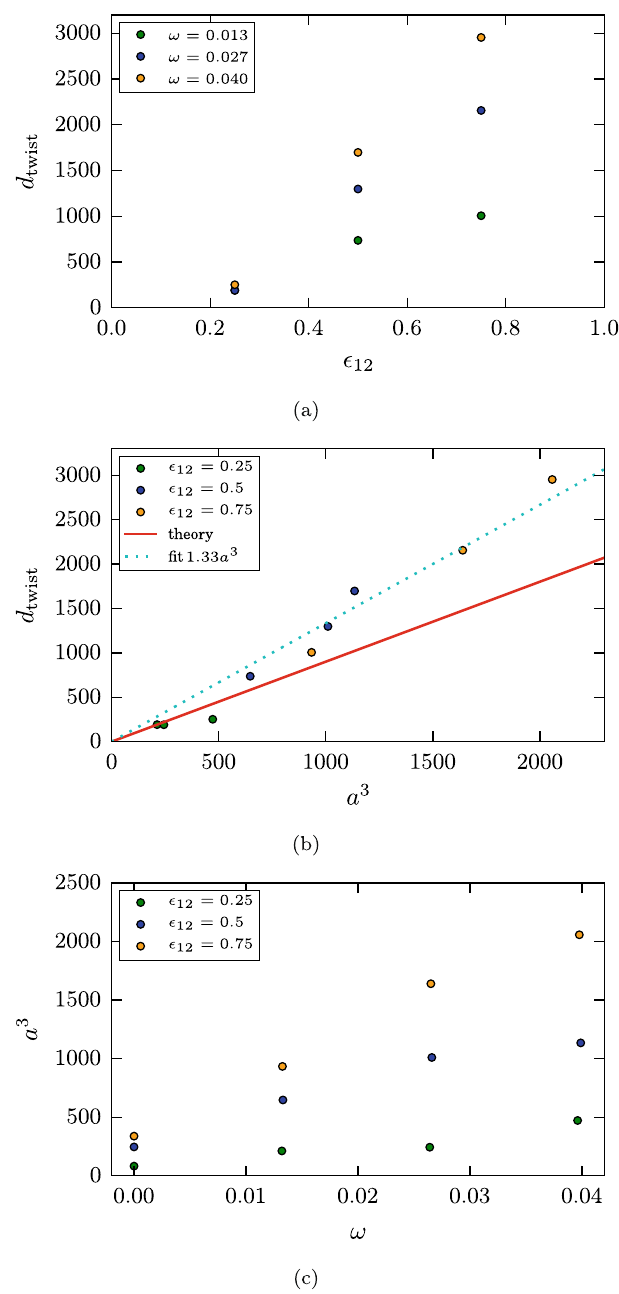
Figure 12. Dependence of the damping torque d twist ( a ) on the intergrain attraction ǫ 12 , and ( b ) on the cube of the contact radius a . The full line gives the theory result, Eq. (5), and the dashed line gives a linear fit. ( c ) Dependence of the cubic contact radius on the angular velocity ω